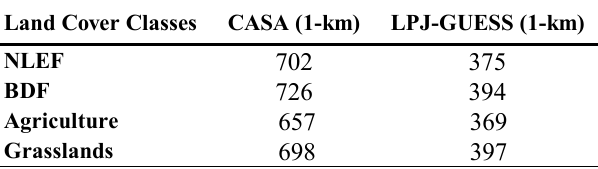
Table.3 . Total annual NPP estimations for the land cover